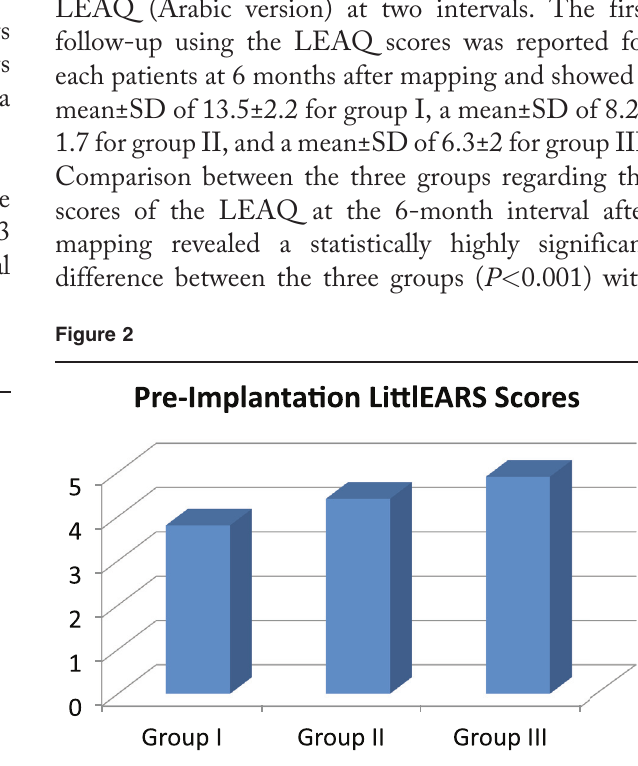
Comparison between the three groups regarding the age of cochlear implantation.